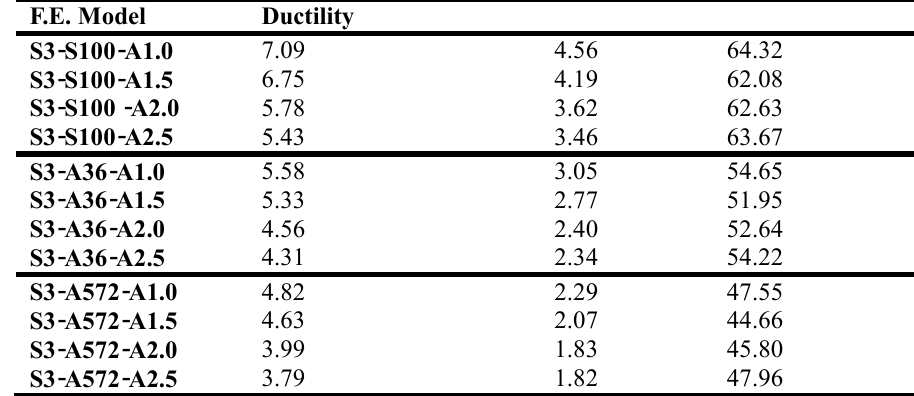
Fig. 13. Ductility of the finite element models of SPSW and moment frame with different spans (3m, 4.5m, 6m, and 7.5m). Ductility of the finite element